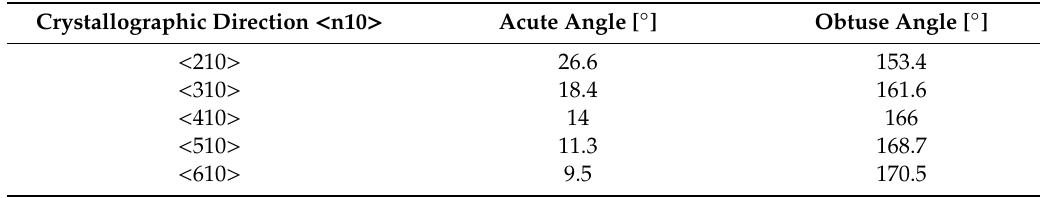
Table 1. The values of acute and obtuse angles of the